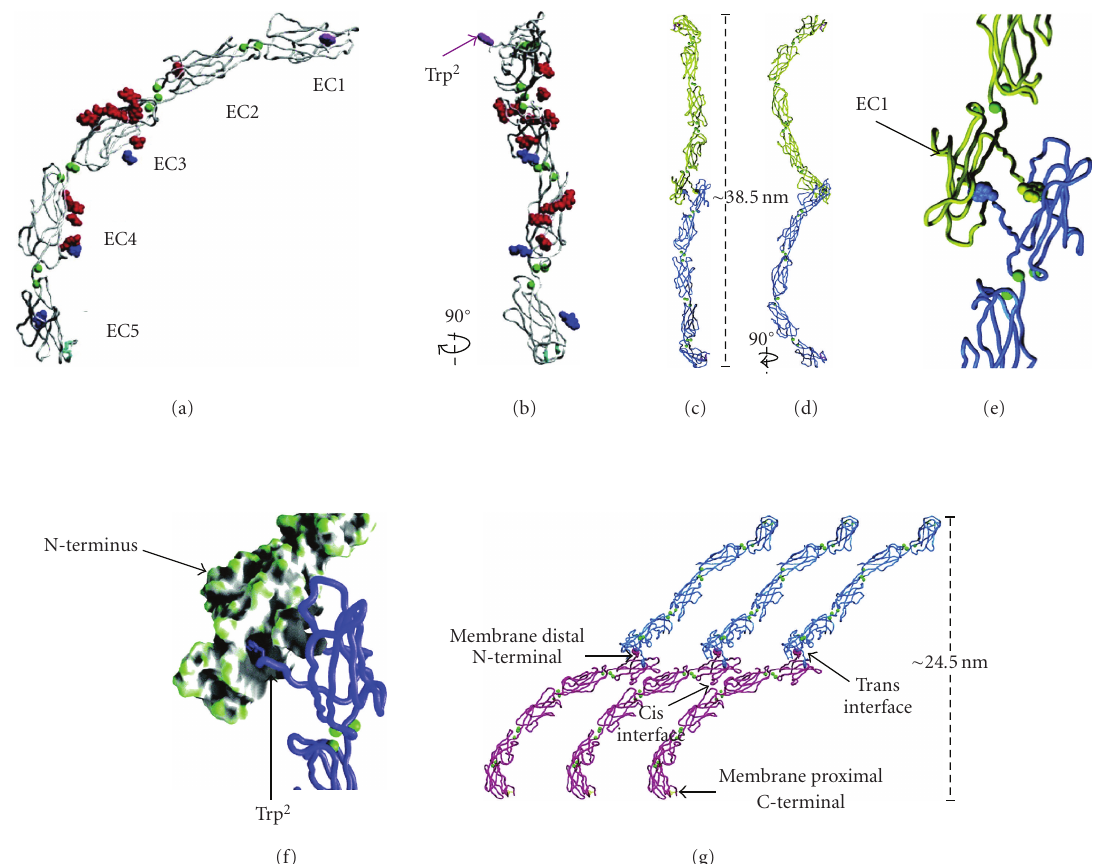
Figure 2: Type I or classical cadherin structure obtained from X-ray crystallographic studies. Structurally the extracellular portion of the cadherin molecule (also known as ectodomains and abbreviated EC) appears as five tandem Ig-like domains, each domain adopting a β - sandwich fold with the topology of a Greek key. Between each domain reside three calcium ions (green spheres) conferring rigidity to the domain interface and inducing the entire structure to assume an extended curve with a defined tilt of ∼ 100 ◦ between the long axes of EC1, and 5. Disulfide bonds, O-linked sugars, and N-linked sugars are represented in cyan, red, and blue, respectively (a). In classical cadherins a conserved tryptophan residue near the N-terminus of EC1 has been shown to be crucial in the process of adhesion and is also conserved in desmosomal cadherins (abbreviated to Trp 2 and is depicted in purple by space filling representation in both a, and b. This Trp 2 is visibly protruding from the cadherin molecule when viewed at 90 ◦ rotation from a (b)) The tip-to-tip associations between the EC1 domains of cadherin molecules from opposing cells membranes form the strand dimer interface (c and at 90 ◦ rotation in d). EC1 domain binding interaction between opposing cadherins is highlighted in the magnified view (e). The side chain of Trp 2 has been suggested as a possible binding site within a hydrophobic pocket in EC1 of a corresponding partner cadherin from the opposing cell membrane. Trp 2 side chains (displayed as a backbone worm trace) can be seen inserting into a large concave cavity (depicted as grey shading in the molecular surface model) of the opposing EC1 domain (f). As the Trp 2 is conserved in desmosomal cadherins it is assumed that the Trp 2 interaction from classical cadherin studies is a compelling model for desmosomal cadherin association, forming a symmetric interdigitation interaction between cadherins of opposing cell membranes, and is known as the strand dimer model (g). Cadherin ectodomains from opposing cells are represented by blue or pink colors. Trp 2 side chains (space filling representation) are depicted in the color representing the cell. Yellow represents disulfide bonds. Modified from [50] reprinted with permission from